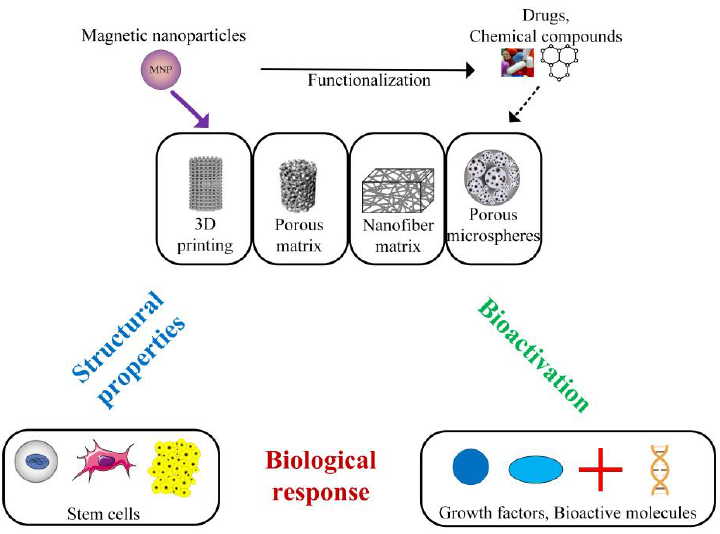
Figure 2. Main components of a magnetic scaffold used in BTE.